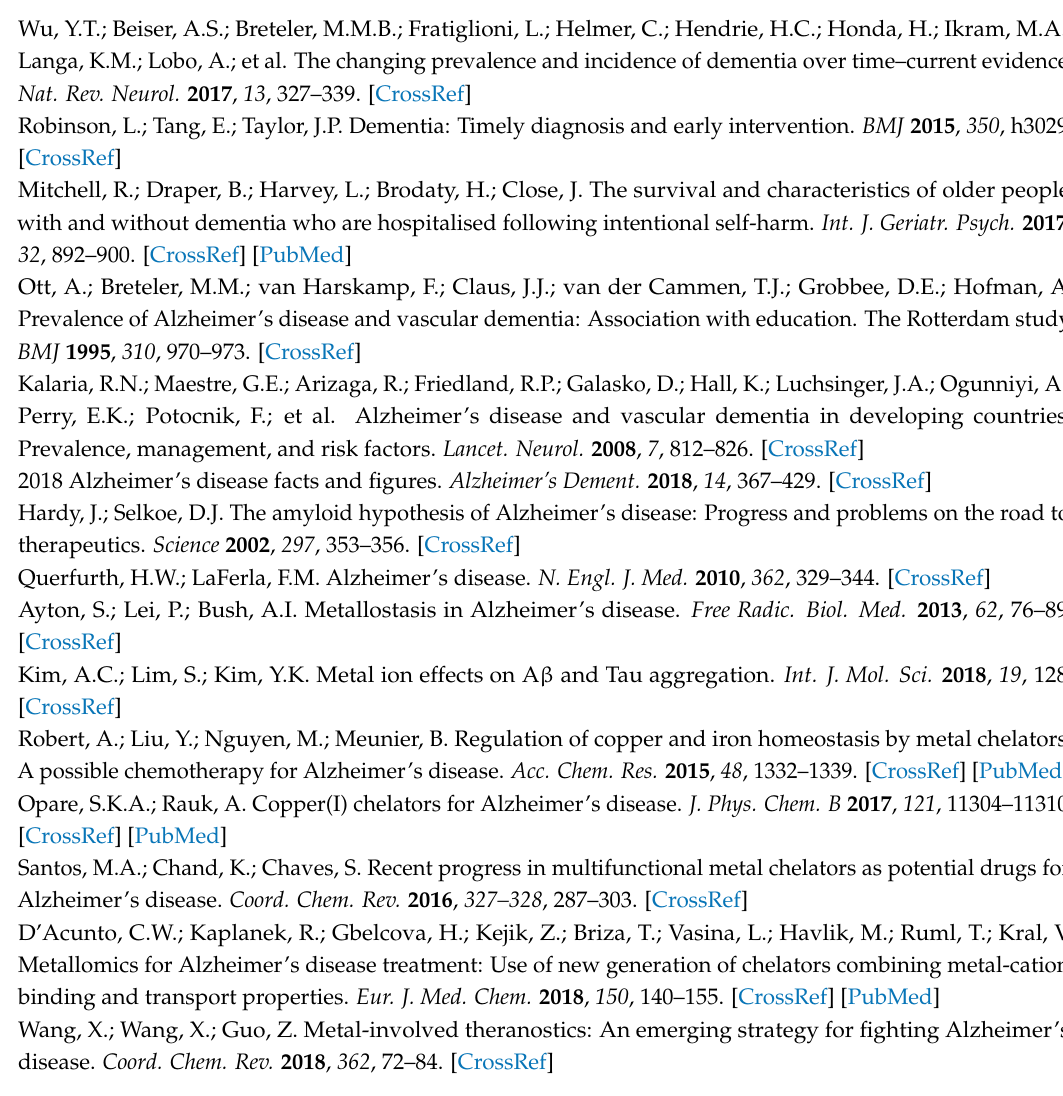
Figure S2. The UPLC chromatogram of CTE. Echinacoside ( 1 ), acteoside ( 2 ), isoacteoside ( 3 ), and tubuloside A ( 4 ) were the components of CTE. Figure S3. The 1 H NMR (500 MHz, CDCl 3 ) data of 1 . Figure S4. The 13 C NMR (125 MHz, CDCl 3 ) data of 1 . Figure S5. The ESI-MS spectrum of 1 . Figure S6. The 1 H NMR (500 MHz, DMSO- d6 ) data of 2 . Figure S7. The 13 C NMR (125 MHz, DMSO- d6 ) data of 2 . Figure S8. The ESI-MS spectrum of 2 . Figure S9. The 1 H NMR (500 MHz, DMSO- d6 ) data of 3 . Figure S10. The 13 C NMR (125 MHz, DMSO- d6 ) data of 3 . Figure S11. The ESI-MS spectrum of 3